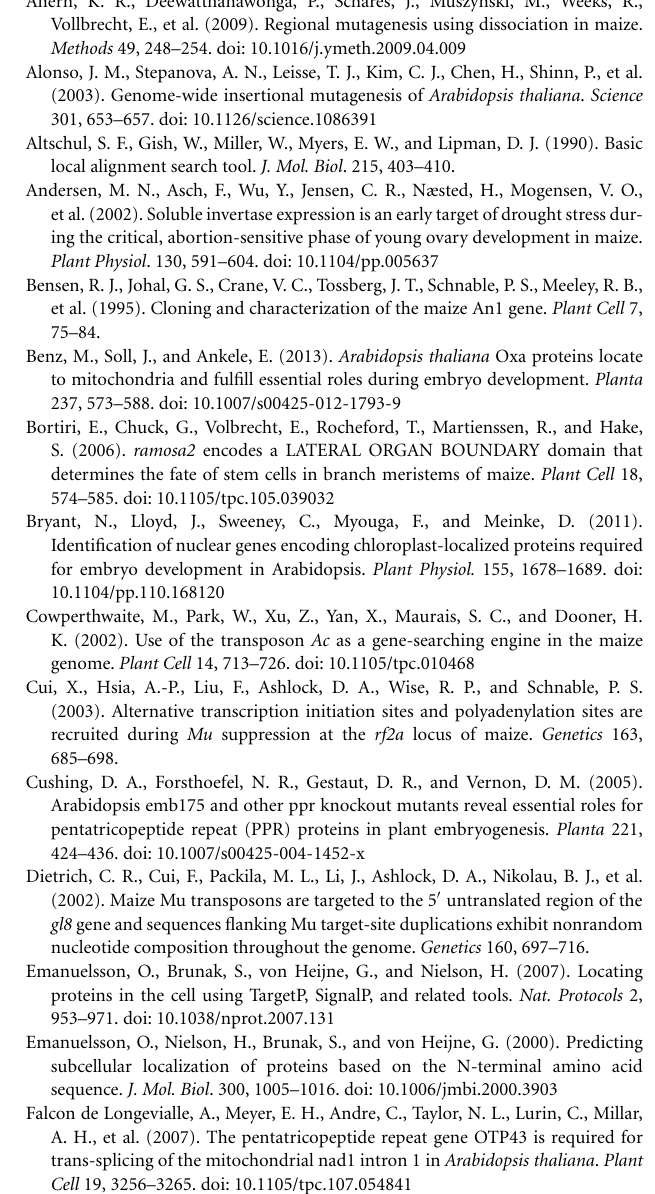
Supplemental Figure 2 | PCR primer sequences and annealing temperatures. Melting temperatures were estimated using the web-based tool from Integrated DNA Technologies (idtdna.com), with all parameters set at default. a Primer was used in genotyping to confirm co-segregation in larger F2 families. b Primer was used in Pool 7 validation experiments. c Supplemental Table 1 | List of Mu insertion locations identified. Insertion positions are presented organized by family of origin. Normalized read counts are shown for pools A through L, corresponding to the 12 plants genotyped for each family. Cells highlighted blue indicate presence of a given insertion (with 50 or more reads detected), and cells highlighted yellow indicate absence of a given insertion (with less than 50 reads